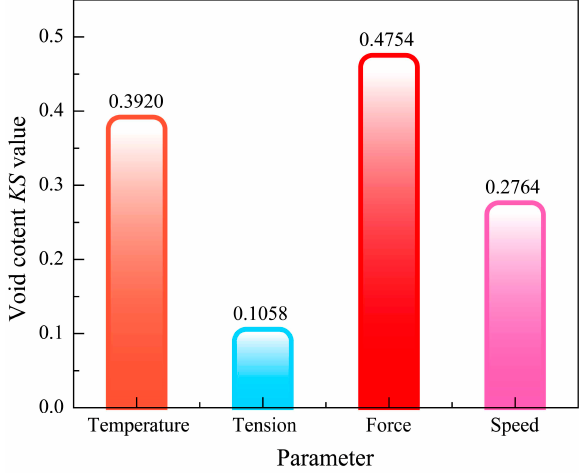
Figure 10. Cartogram of KS values for the void content model.